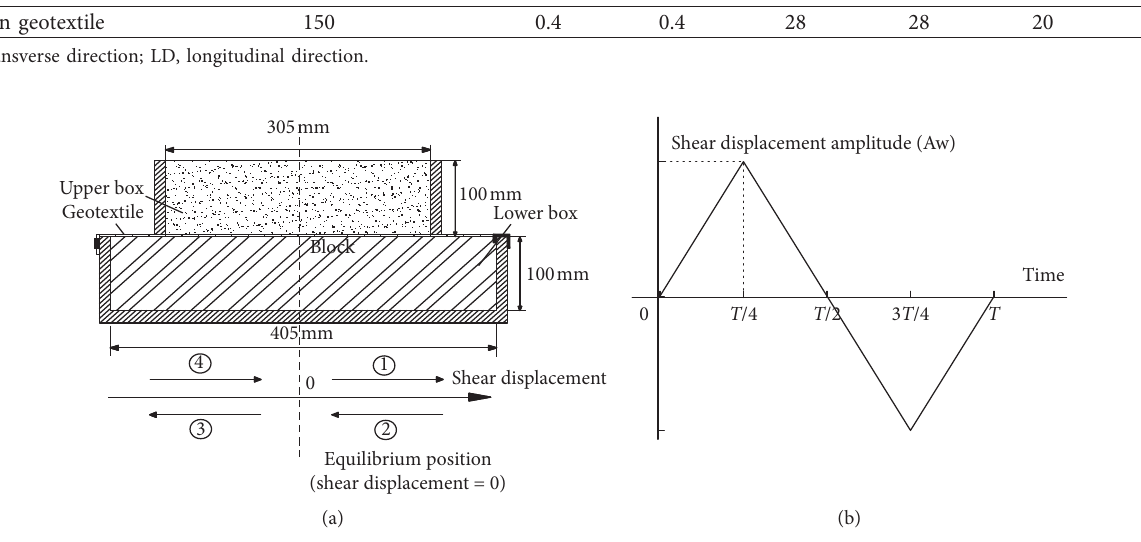
Figure 2: Schematic of the cyclic shear paths. (a) The cyclic shear path. (b) Waveform of cyclic